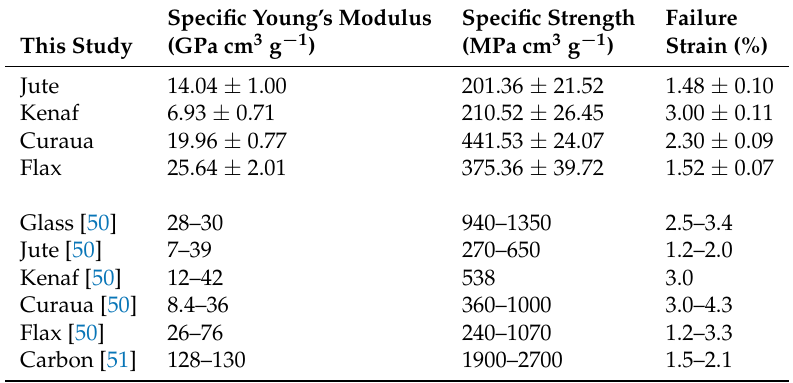
Table 3. Specific mechanical properties of jute, kenaf, curaua, and flax fibres compared with literature values of natural and synthetic fibres. Errors represent